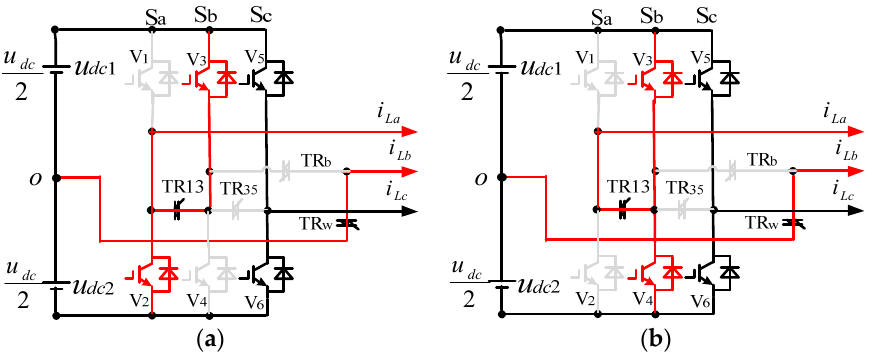
Figure 2. The secondary reconfiguring process of the inverter: ( a ) the first reconfiguration; ( b ) the secondary reconfiguration.